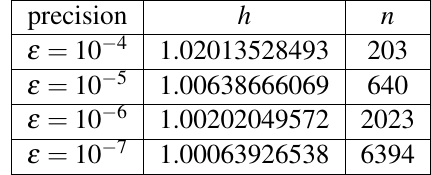
Table 4 Performances when computing h ( g 0 . 1 , 0 . 9 ) in bits with the trimodal